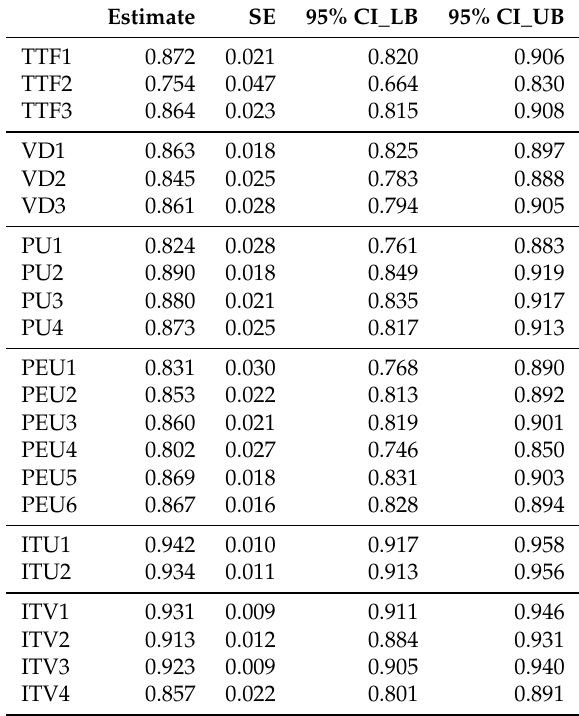
Table 5. Estimates of